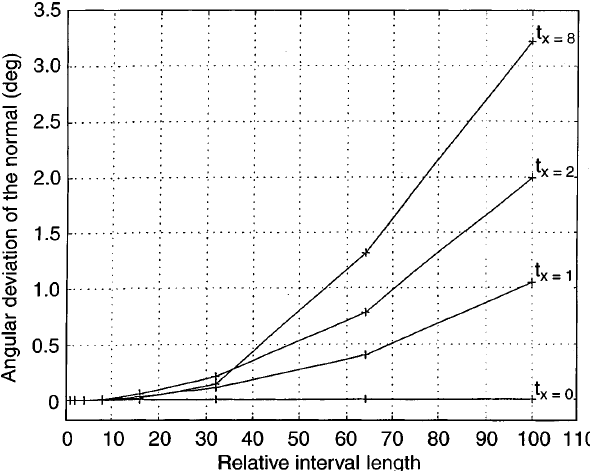
where 2 r is the boundary thickness, B is a constant with units of 0l length times magnetic field and R is the radius of curvature of the discontinuity surface. The field line topology is indicated in Fig. 3. In this model the strength of the field decreases to zero on approaching Fig. 5. Sensitivity of MVA analysis to the model shown in Figure 5 in the boundary from one side, before flipping direction and increasing terms of its strength on the other side